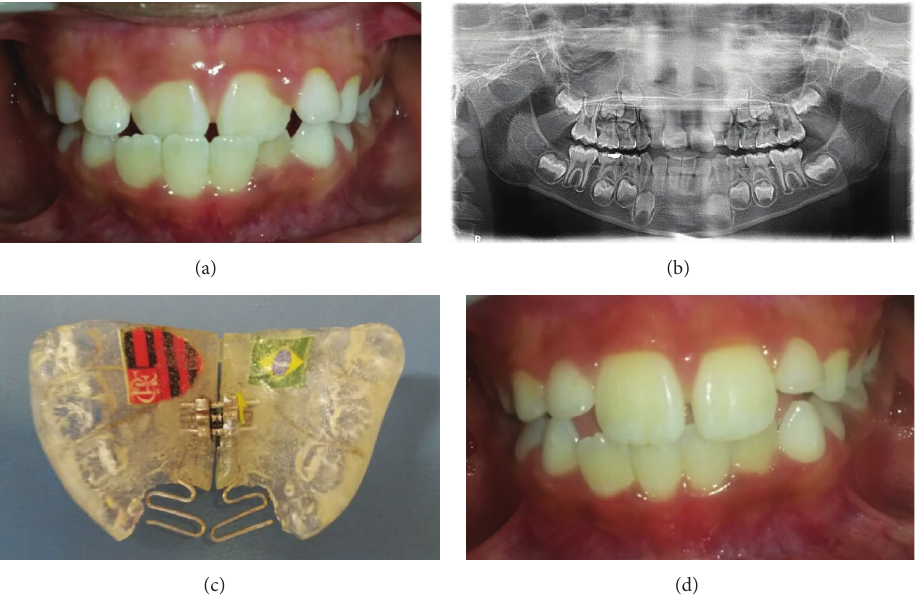
Figure 2: Case 2. (a) Anterior dental crossbite in the two upper central incisors. (b) Panoramic radiograph showing no abnormality. (c) Removable orthodontic appliance with a protrusion spring for each incisor in anterior crossbite. (d) Anterior crossbite correction after 5